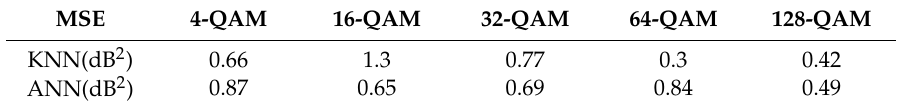
Figure 10. The identification accuracy of ( a ) ANN algorithm and ( b ) KNN algorithm. Table 3. The MSE of KNN and ANN algorithm.